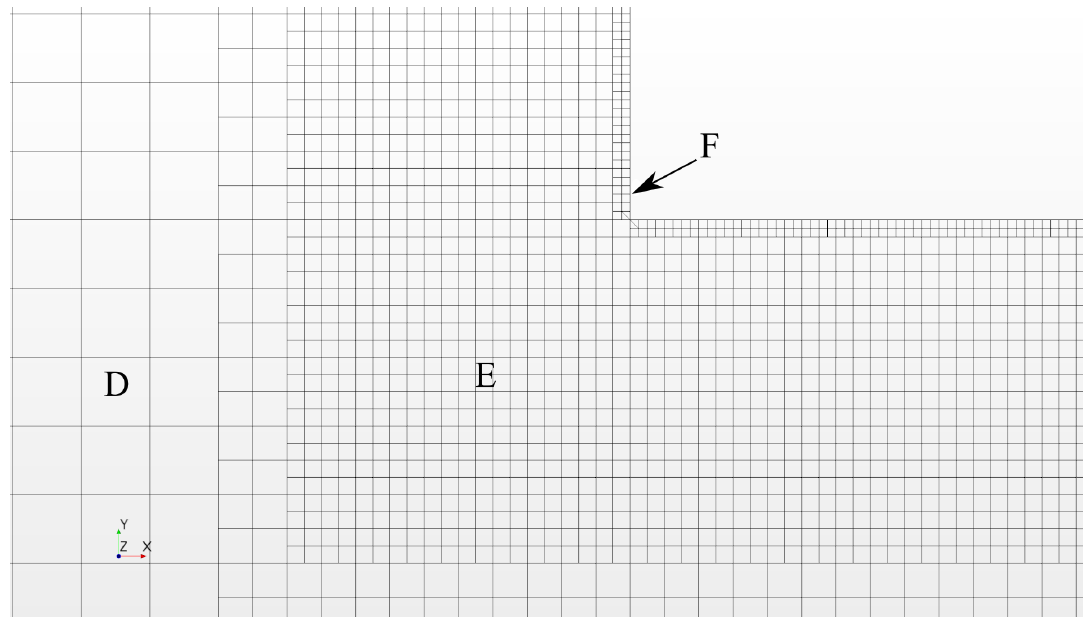
Figure 6. Cylinder corner mesh viewed at cylinder center line. Table 1. Grid spacing values non-dimensionalized by cylinder height